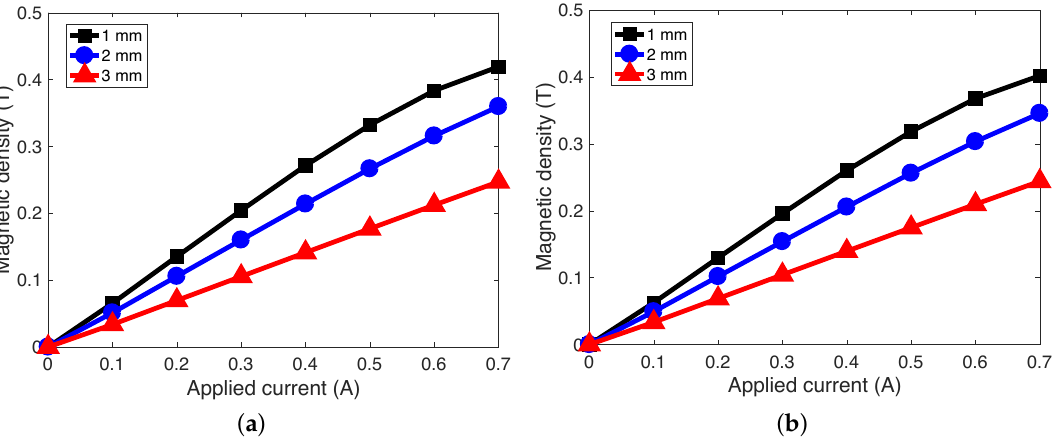
Figure 3. One example of the analytical electromagnetic characteristics of the MRE-DVA at an applied current input of 0.7 A: ( a ) magnetic field contour (2 mm gap case) and ( b ) magnetic density versus bobbin length.